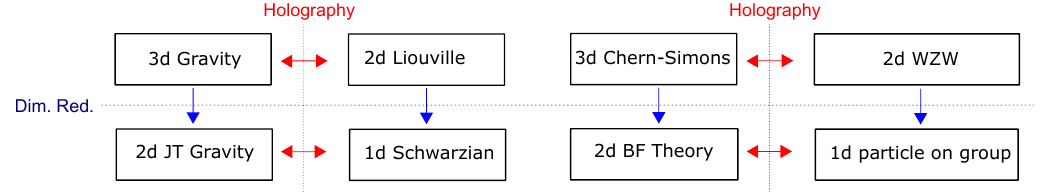
Figure 1 . Scheme of theories and their